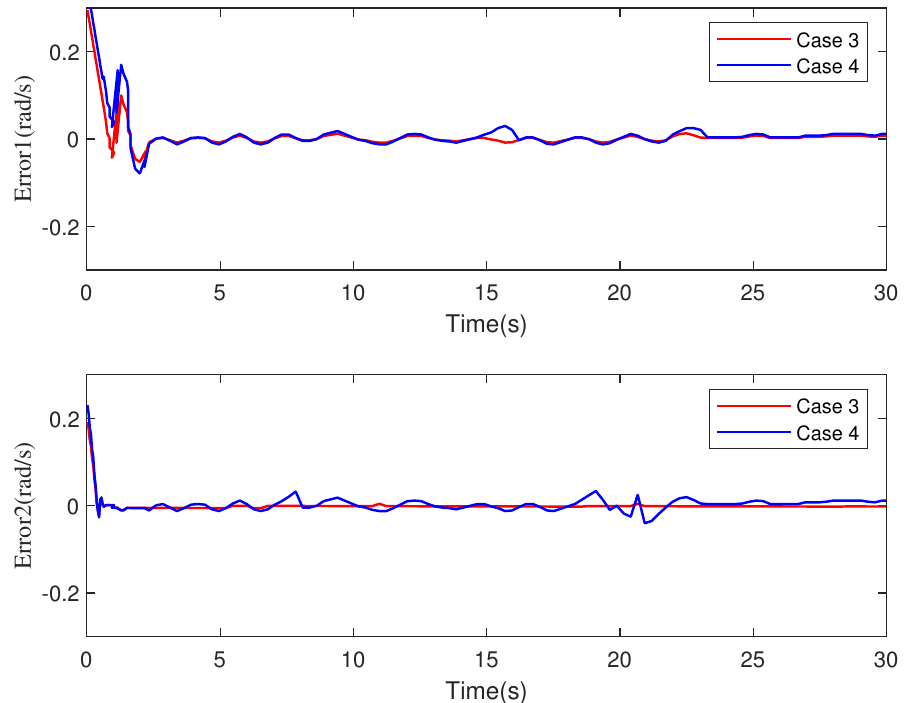
Figure 12. Velocity estimation errors with time-varying external disturbances in Case 3 and Case 4 for the 2-DOF robot